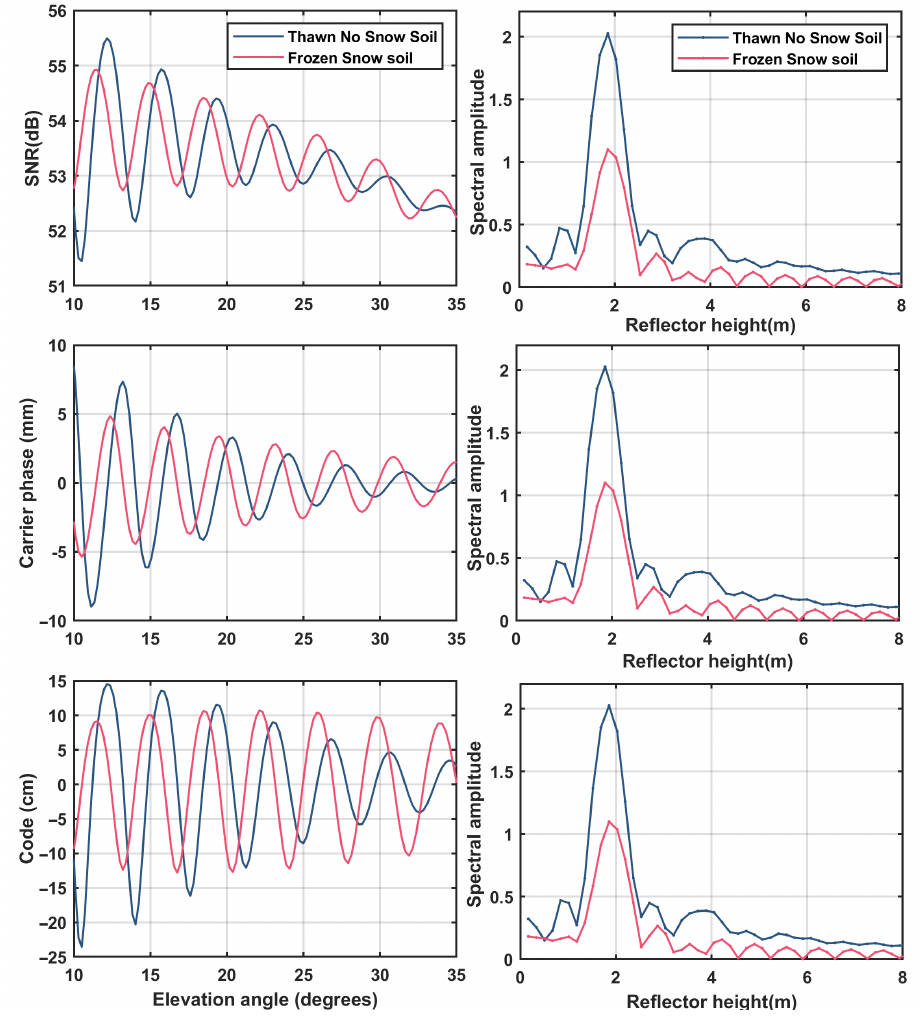
Figure 10. Changes in GNSS multipath observation and effective reflectometer height when the frozen surface is covered with snow and the melted surface is not covered with